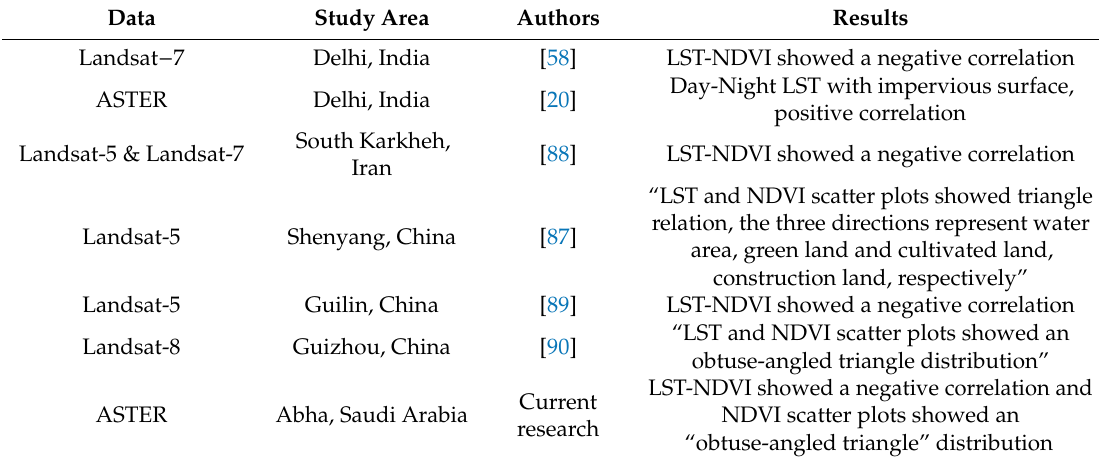
Table 6. Research findings relationships between LST and NDVI. Data